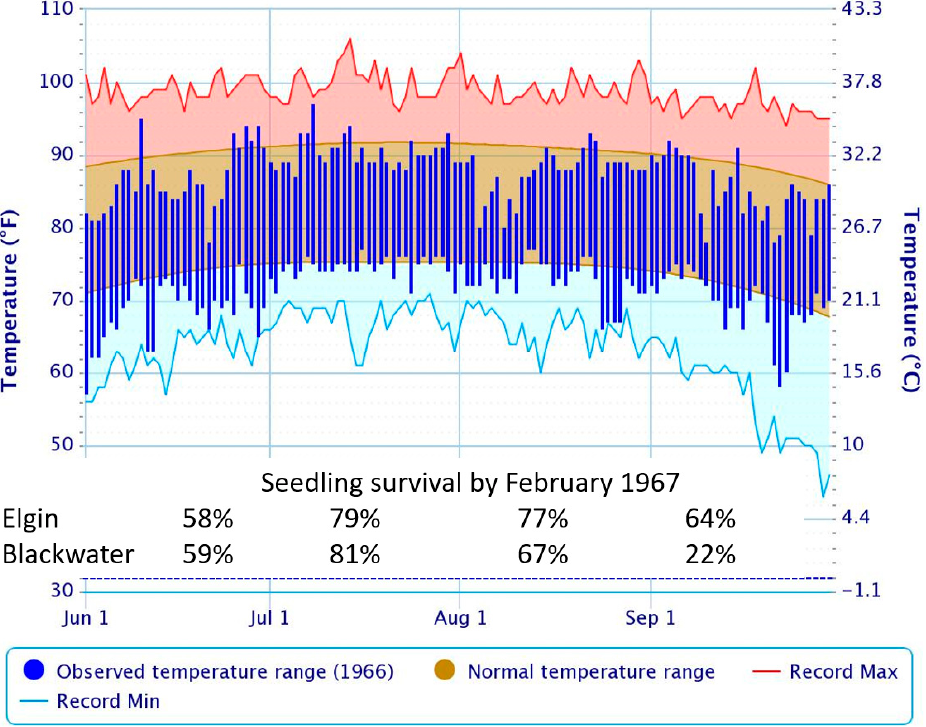
Figure 29. Seedling survivals for bareroot slash pine in Florida vary by planting location and month. Data from [181]. Survival of June planted stock was 58% when planted at the Elgin Air Force Base and 59% when planted at the Blackwater State Forest in Florida. Air temperatures for the Pensacola regional airport for the year 1966 were provided courtesy of the Applied Climate Information System. The highest temperature of the year was 36.1 ◦ C on 8 July 1966. Data for maximum and minimum temperatures began in 1948.